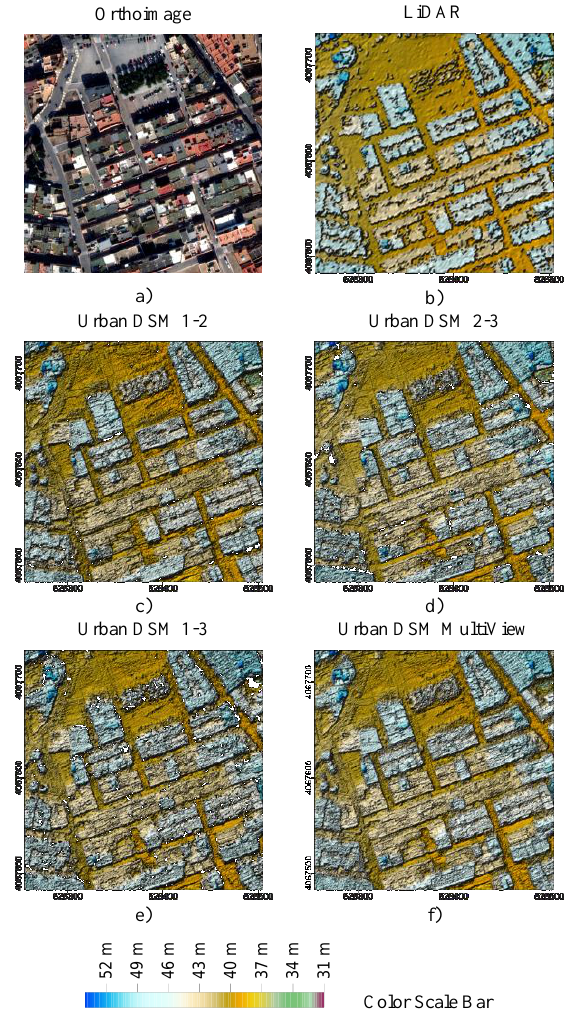
Figure 6. DSMs extracted for urban land cover: a) WV3 RGB orthoimage; b) LiDAR data; c) Urban DSM 1-2; d) Urban DSM 2-3; e) Urban DSM 1-3; f) Urban DSM MultiView.